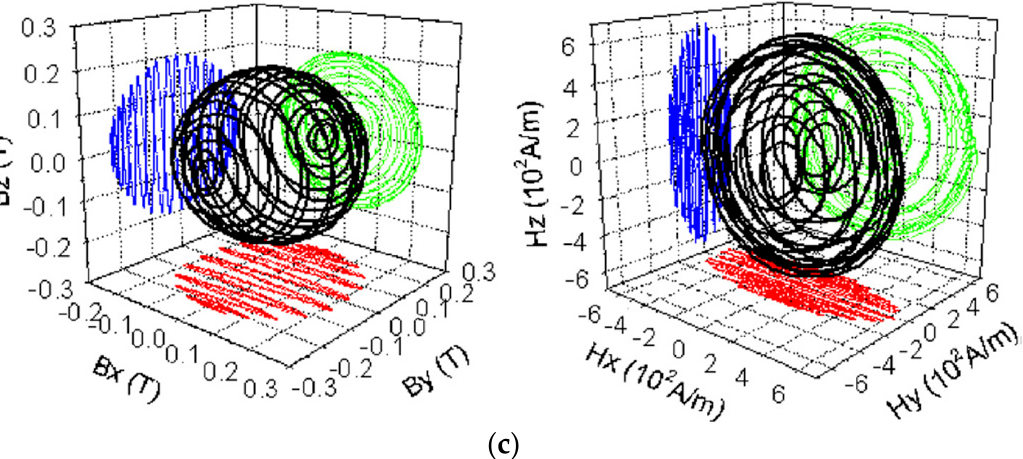
Figure 4. Experimental results of SMC samples at 50 Hz: ( a ) B-H relation and associated core loss under 1D alternating sinusoidal B; ( b ) B-H relation under 2D circularly rotating B; and ( c ) B-H relation under 3D spherical B.